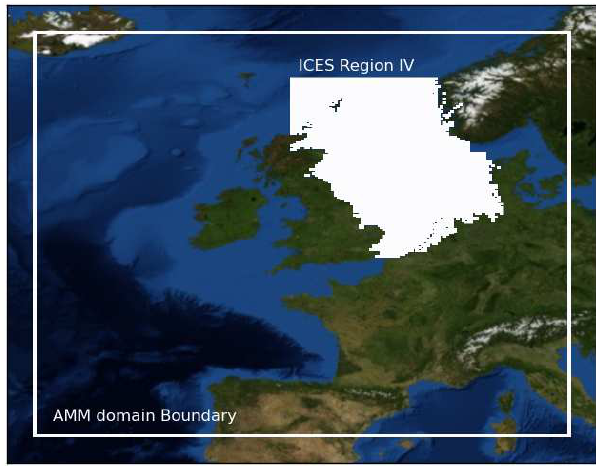
Fig. 1. The Atlantic Margin Model (AMM) boundary and the North Sea as defined by ICES region IV.